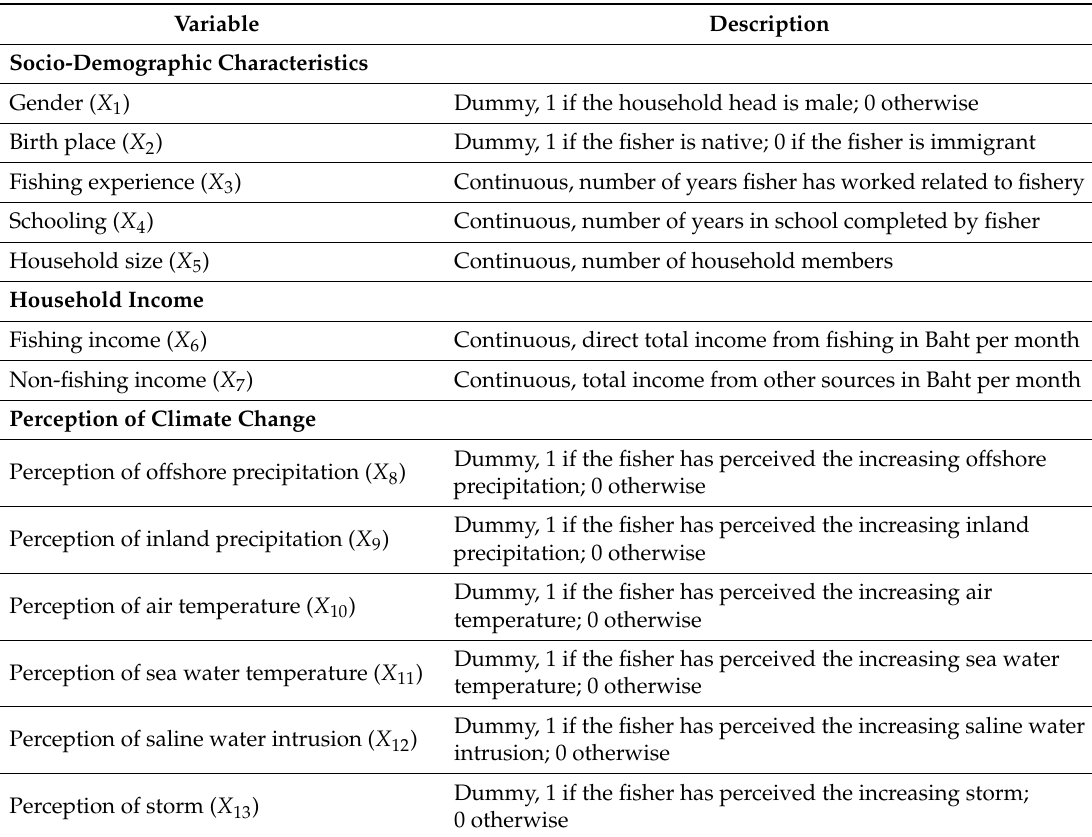
Table 1. Explanatory variables in the binary logistic regression